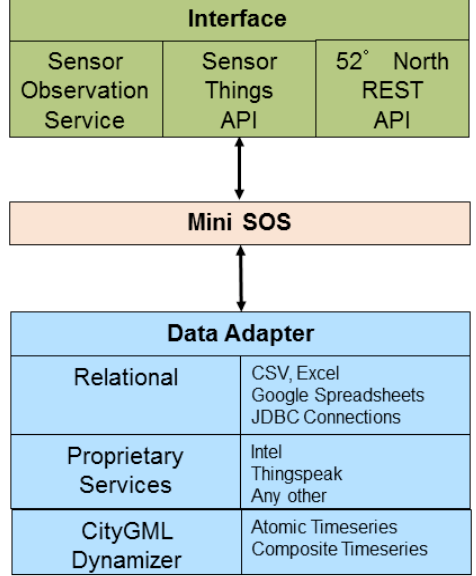
Figure 5. The conceptual illustration of Mini Sensor Observation